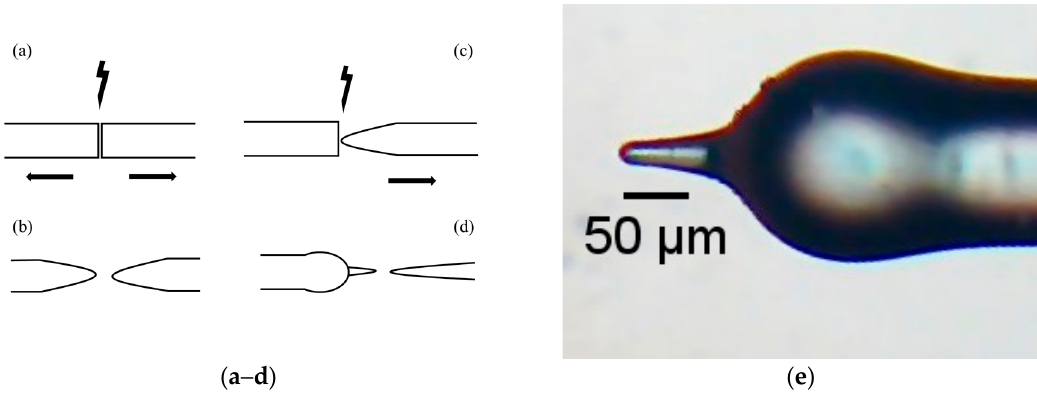
Figure 1. Manufacture steps ( a – d ) and head sensor ( e ).